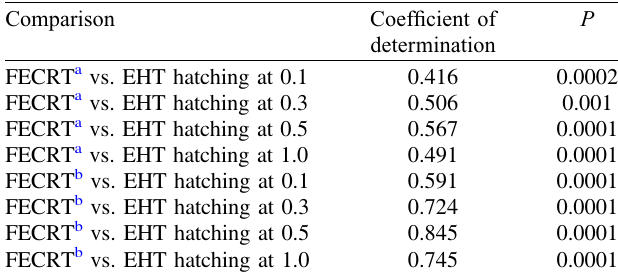
Table 4. Coef fi cients of determination and p values for comparing the results of the faecal egg count reduction test (FECRT) and percentage hatching in the egg hatch test (EHT) at the four highest concentrations of thiabendazole ( l g/mL) in a fi eld survey of 30 goat farms.